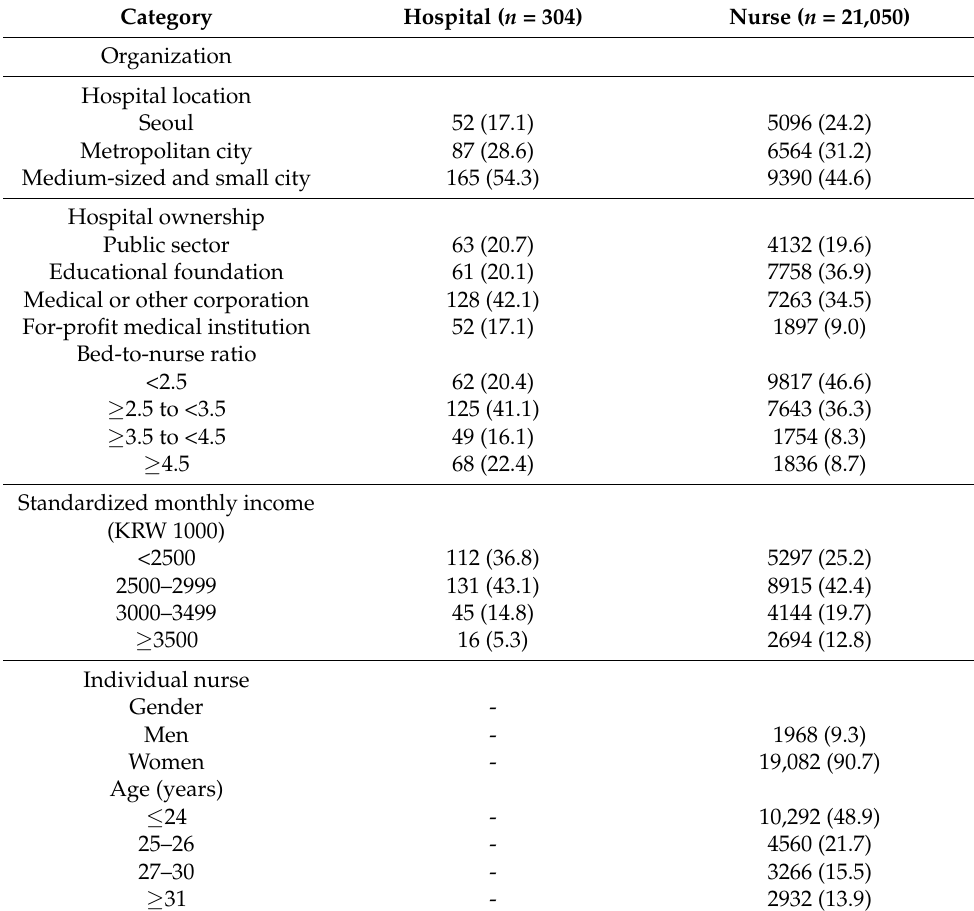
Table 1. Organizational and individual